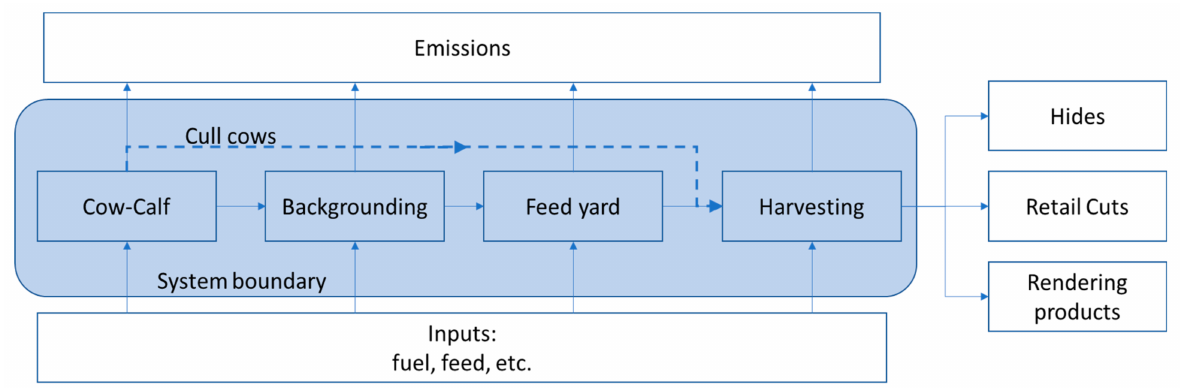
Figure 1. Beef lifecycle stages. Note that this is not representative of all potential pathways; sometimes weaned calves leave the cow/calf stage directly to feed